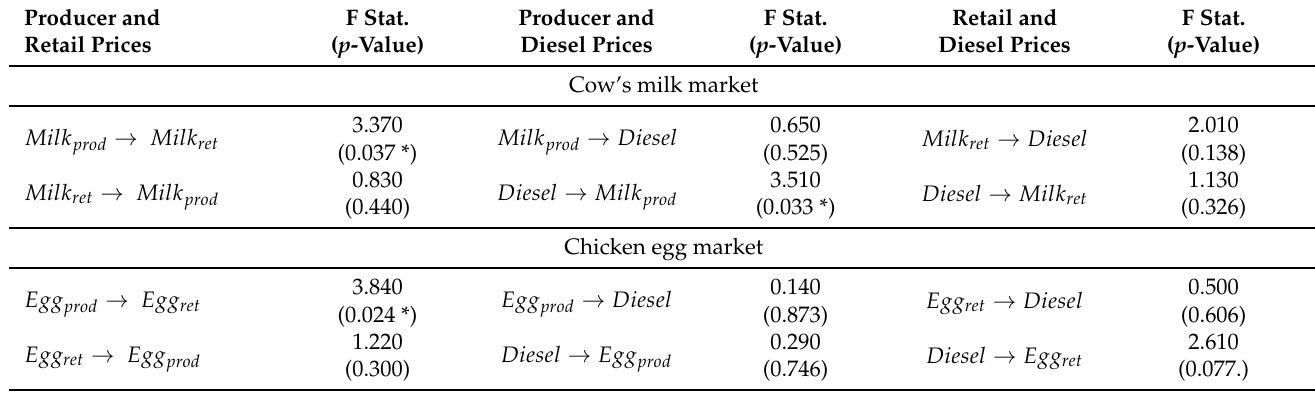
Table 7. Granger causality